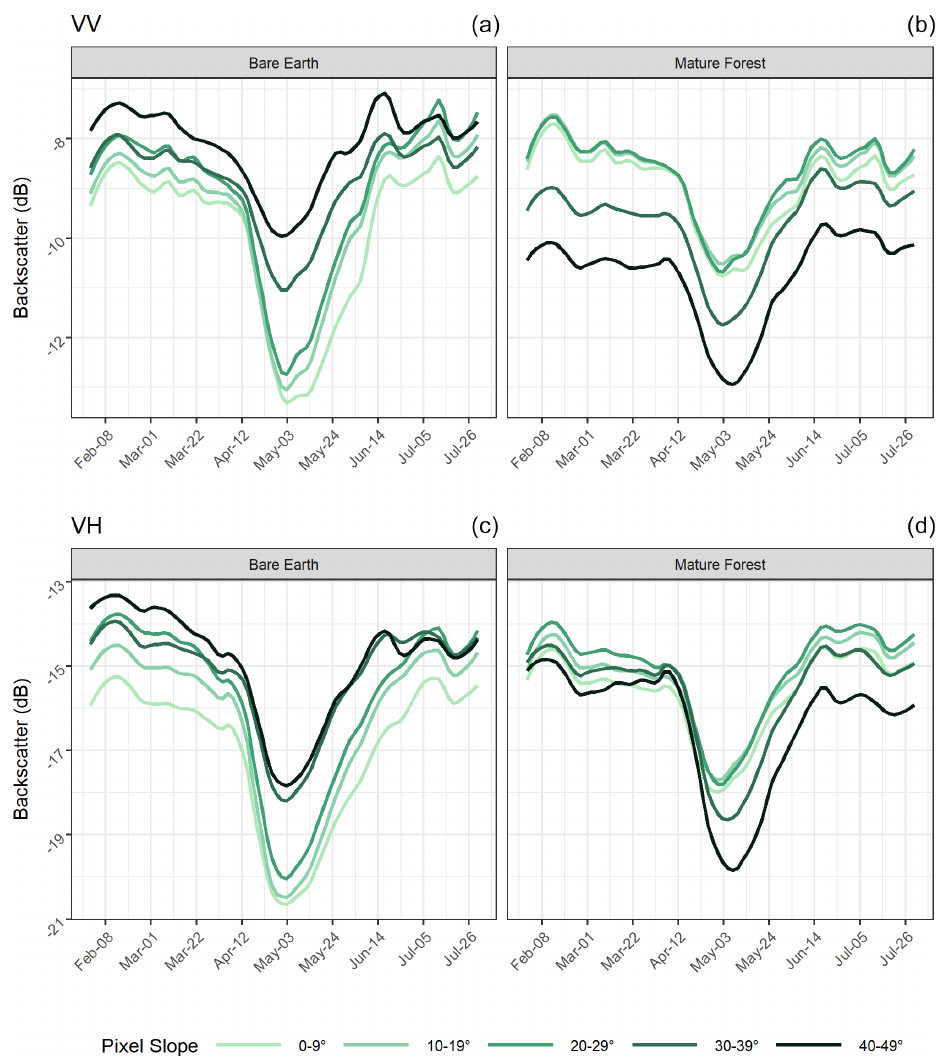
Figure 5. SAR backscatter time series in the La Joie Basin from pixels located between 1600 and 1800m from VV (a, b) and VH (c, d) polarized images. Observations under mature forest cover are displayed on the right (b, d) , whereas observations in open areas are displayed on the left (a, c) . Average backscatter for each cover type is shown by the shaded lines, with each line representing a different slope category. Observations are from